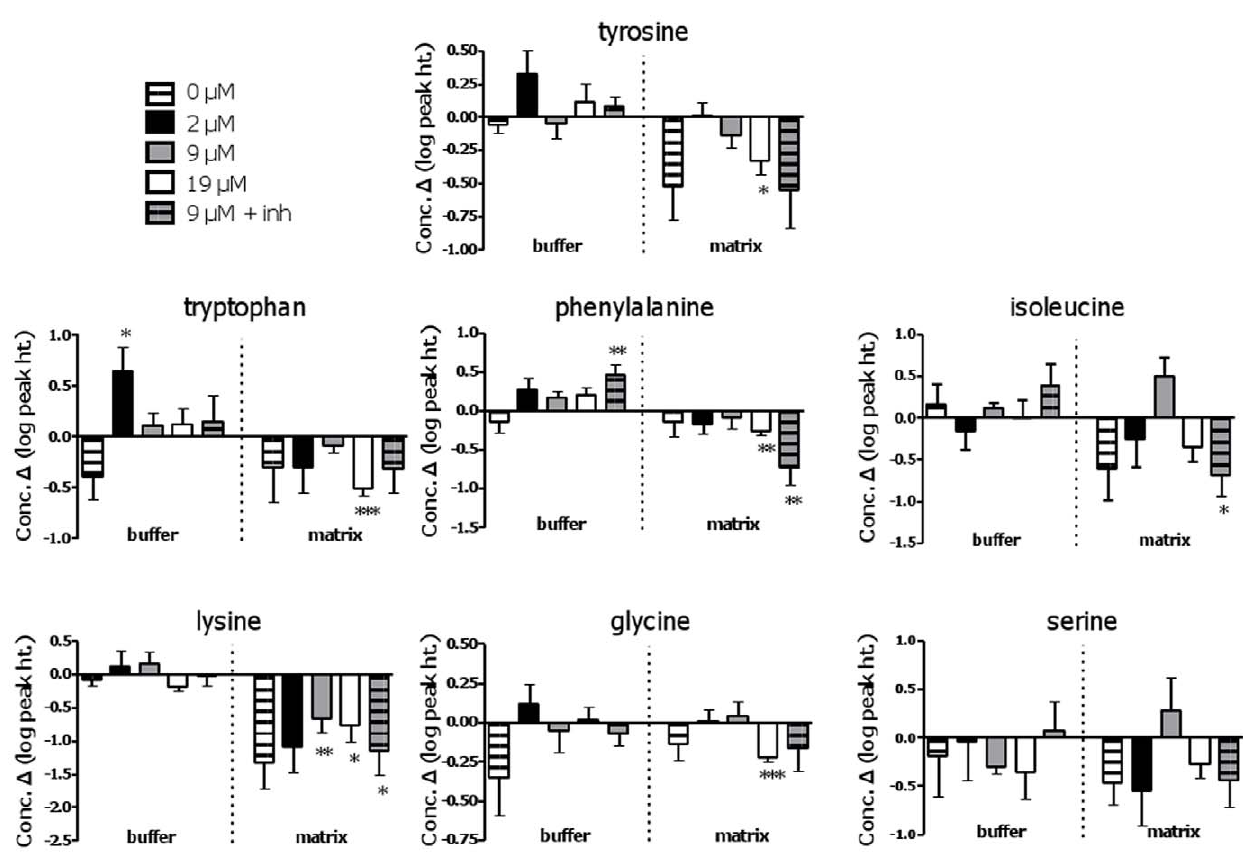
Figure 6. Changes in detected amino acids over time in buffer and matrix fractions obtained from muscle mitochondrial preparations. Significance: paired t-test, 0 vs . 20 min, within treatment; * P , 0.05; **, P , 0.02, *** P , 0.005. See legend to Figure 5 for further details.